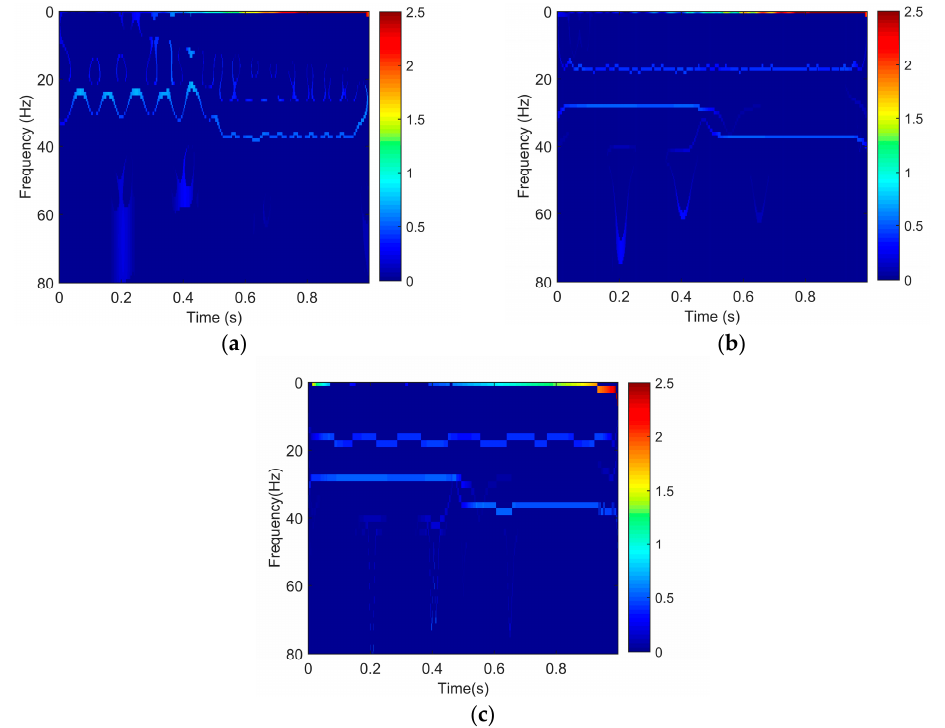
Figure 2. Time-frequency spectra of the synthesized signal based on ( a ) synchroextracting transform (SET); ( b ) empirical wavelet transform (EWT) combined with SET (EWT-SET); and ( c ) EWT combined with Hilbert transform (HT) (EWT-HT).